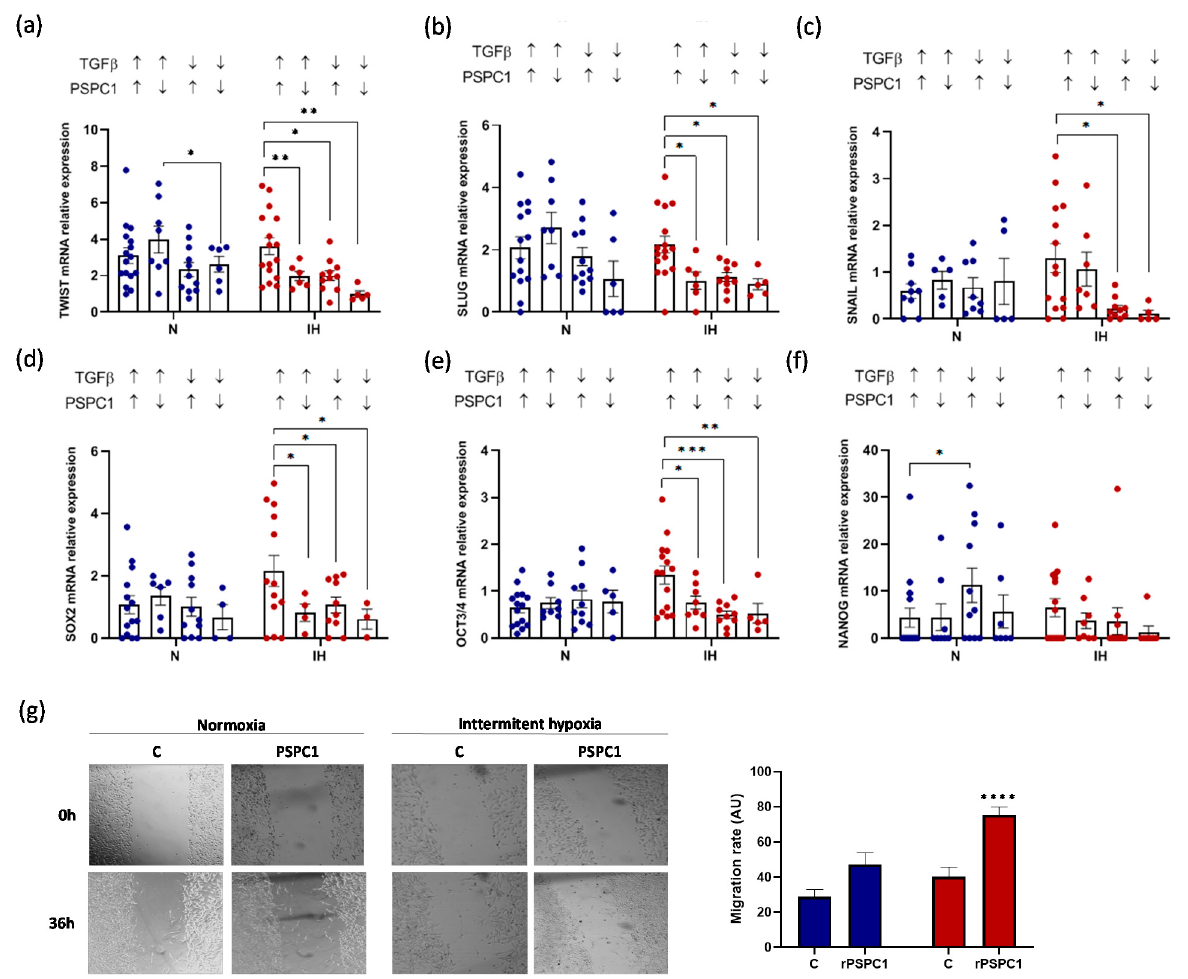
Figure 5. The synergistic effect of PSPC1 and TGF β enhances the expression of EMT-TFs. The melanoma cell line was cultured under normoxia and IH conditions with plasma from patients with OSA (10% concentration) for 16 h. OSA plasma was selected according to PSPC1 and TGF β protein concentrations. We established four groups: PSPC1-high (200–2000 pg/mL) with TGF β -high (5–100 pg/mL) as group 1, PSPC1-low (30–200 pg/mL) with TGF β -high (5–100 pg/mL) as group 2, PSPC1-high (200–2000 pg/mL) with TGF β -low (0–5 pg/mL) as group 3, and PSPC1-low (30–200 pg/mL) with TGF β -low (0–5 pg/mL) as group 4. The melanoma cells were then harvested to analyze the mRNA expression by qPCR analysis. EMT transcription factor mRNAs were analyzed through TWIST ( a ), SLUG ( b ), and SNAIL ( c ) mRNA expression estimation by qPCR. CSC transcription factor mRNAs were analyzed through SOX2 ( d ), OCT3/4 ( e ), and NANOG ( f ) mRNA expression. The comparison between groups was performed with a two-way ANOVA. Error bars: SEM. * p < 0.05, ** p < 0.001 and *** p < 0.0001 compared with the treated group, respectively. ( g ) C-8161 cells were incubated with TGF β (50 pg/mL), with or without PSPC1 (2,5 ng/mL) under normoxia and intermittent hypoxia for 36 h. Representative cell images from each group in the indicated time points are shown; ( left panels). Quantification of wound healing is shown ( right panels). Data were analyzed by two-way ANOVA. Results are expressed as means ± SEM ( n = 3). **** p < 0.0001.